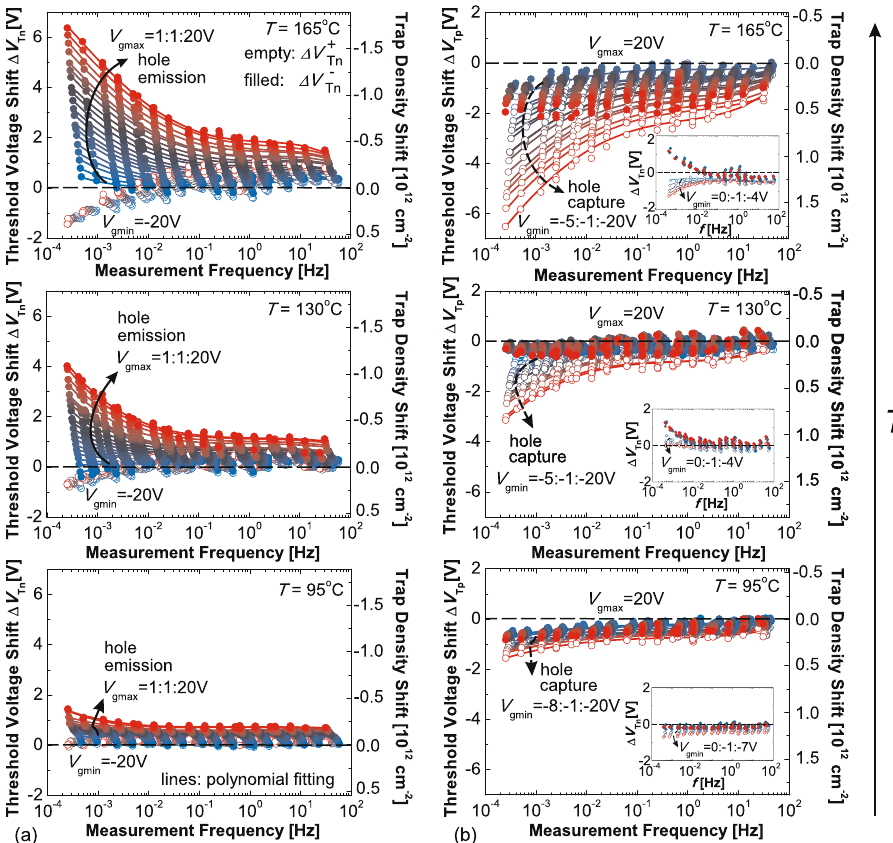
Fig. 3 a The Δ V þ ( f ) and Δ V (cid:2) ( f ) characteristics obtained at T = 95 °C, T = 130 °C and T = 165 °C for V gmin = − 20 V and V gmax from 1 to 20 V. While Tn Tn for larger V gmax the number of defects which can emit a hole becomes larger, the distances between the Δ V (cid:2) concentrations of oxide traps which discharge within the corresponding V g interval. b The Δ V þ same temperatures using V gmax = 20 V and different V gmin . Since V gmin determines the number of traps which can become charged, we analyze the distances between the Δ V þ ( f ) curves. However, since for narrow sweep ranges Δ V þ Tp curves ( inset